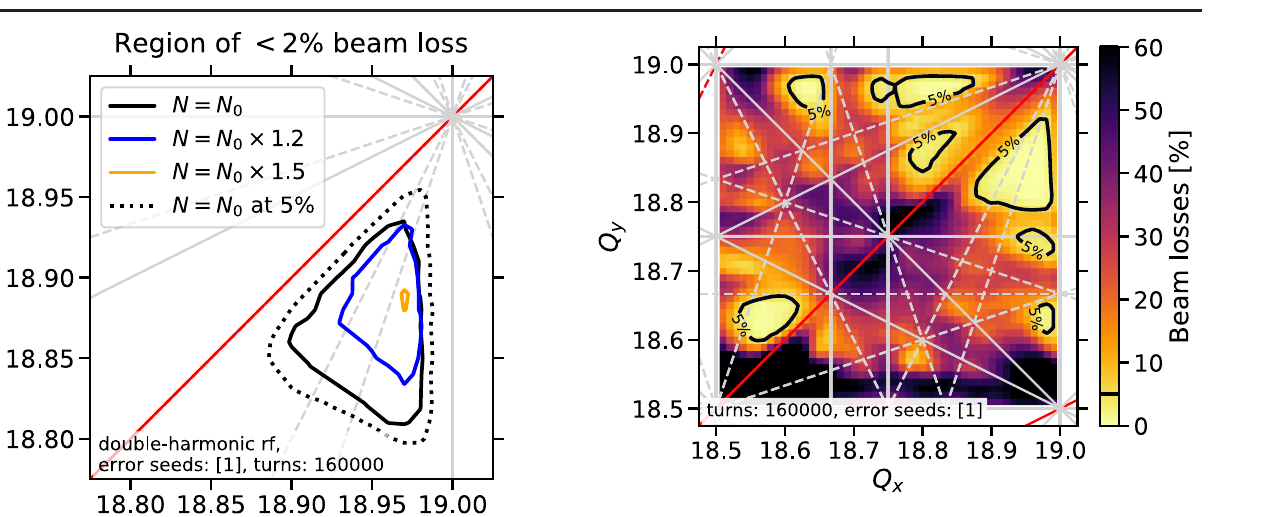
FIG. 19. Three pulsed electron lenses mitigate space charge. Beam-loss tune diagram after injection plateau, obtained from the FFSC simulation model with the magnet field errors